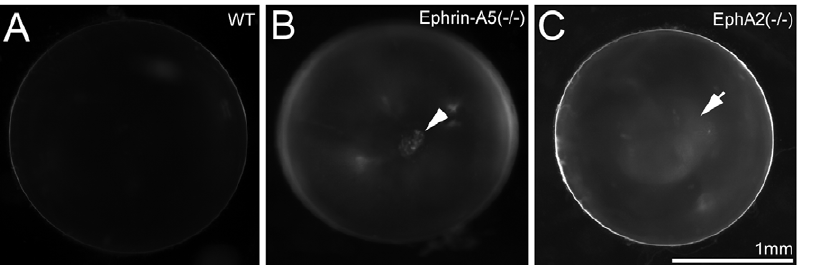
Figure 1. Different types of cataracts occur in ephrin-A5(-/-) and EphA2(-/-) mice. Photos of enucleated fresh lenses from P21 wild-type (WT) (A), ephrin-A5(-/-) (B) and EphA2(-/-) (C) mice. A representative ephrin-A5(-/-) lens photo shows an obvious cataract at the anterior pole (arrowhead in B). A representative EphA2(-/-) lens displays mild nuclear opacity (arrowheads in C). Scale bar, 1mm.